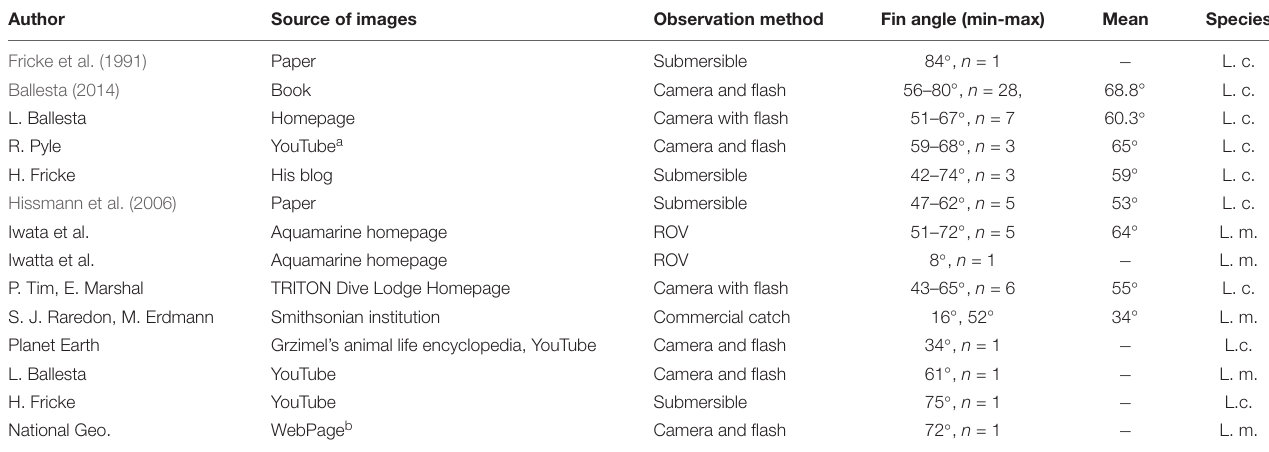
TABLE 2 | The state of the angle of the first dorsal fins of coelacanths of Latimeria chalumnae (L. c.; East Africa region) and L. menadoensis (L. m.; Indonesia) in some selected reports or sources listing the number of angle measurements and the mean